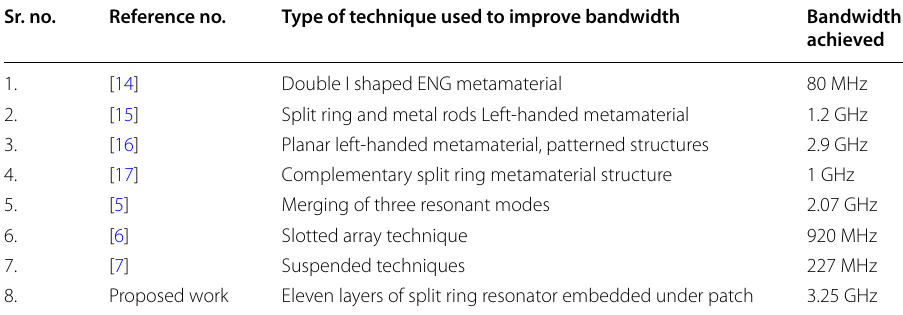
Table 2 Comparison of proposed work with other similar works Sr.